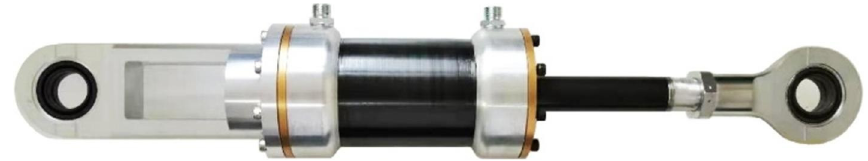
Figure 7. CFRP hydraulic cylinder prototype designed by Li et al. [2].